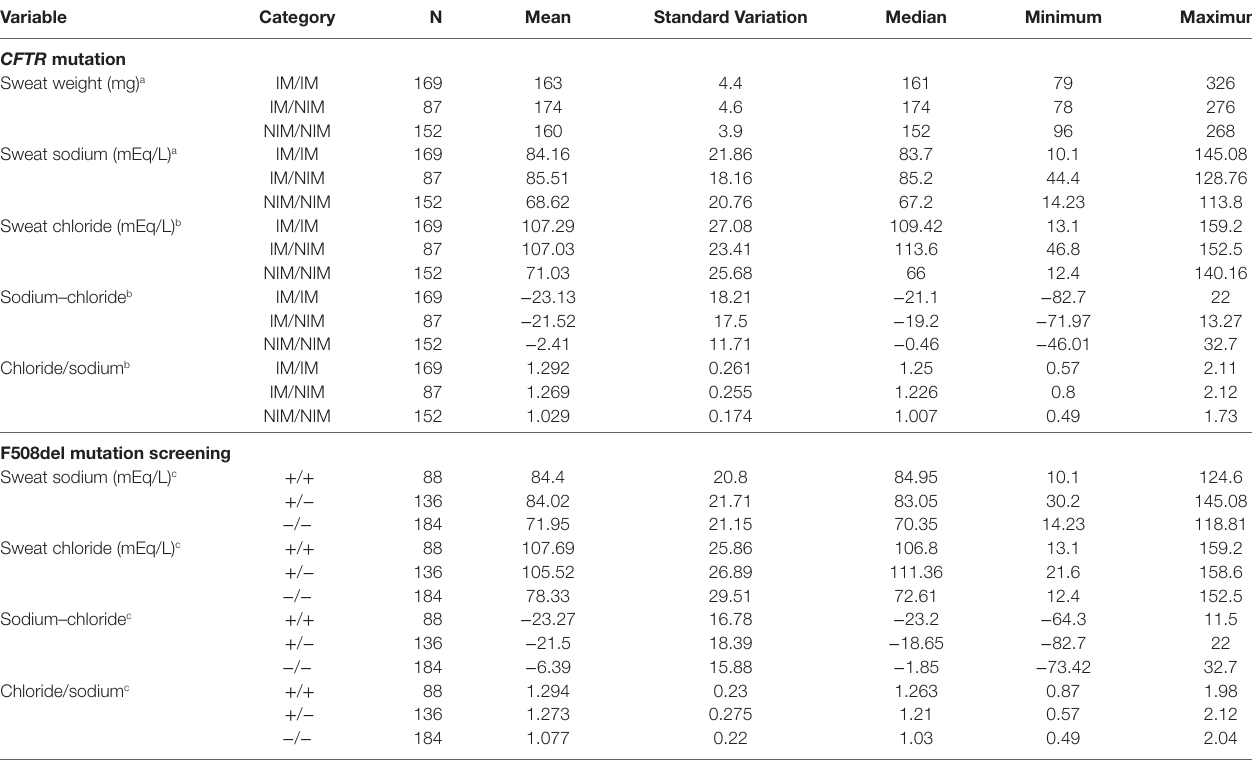
Table 7 | Association between sweat test markers and CFTR mutation screening.